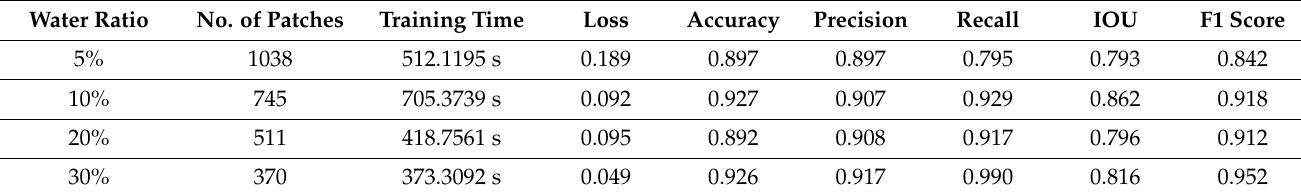
Table 3. Accuracy of image segmentation by waterbody ratio.